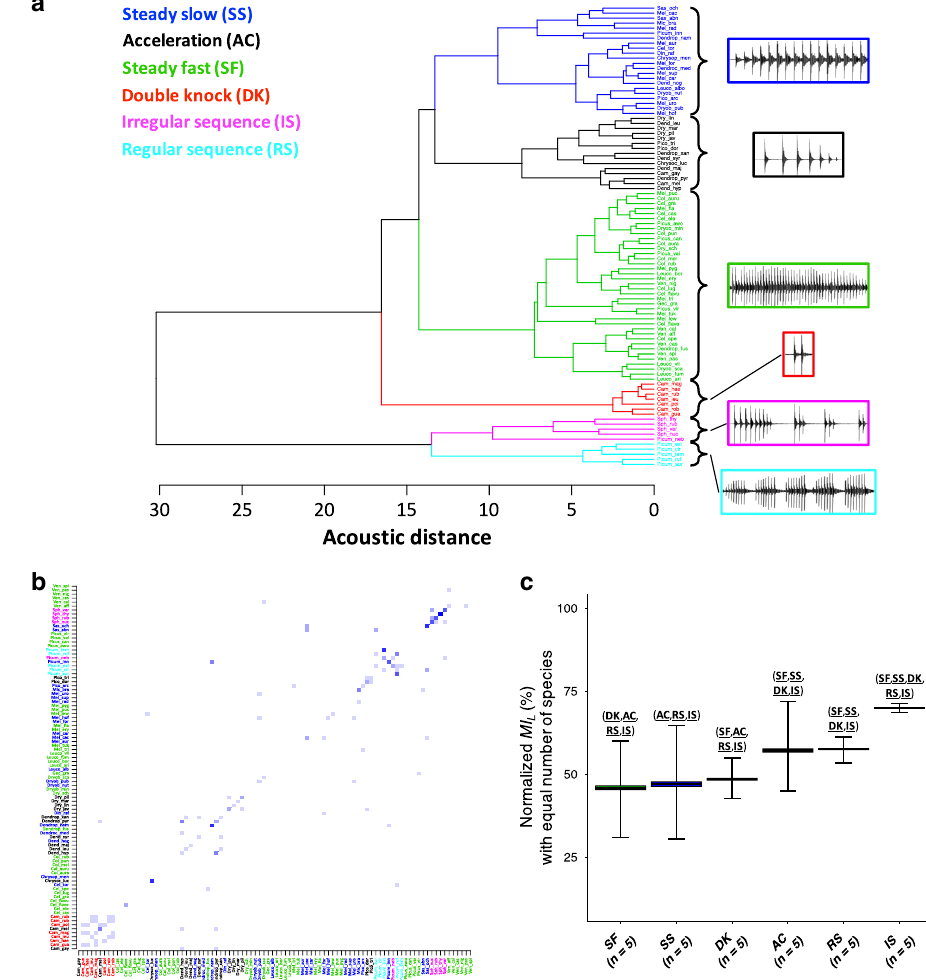
Fig. 2 Quanti fi cation of signal structure and information for species identity. a Hierarchical clustering of drumming signals based on acoustic Euclidean distances. Oscillograms illustrate the six drumming types: ‘ steady slow ’ , ‘ acceleration ’ , ‘ steady fast ’ , ‘ double knock ’ , ‘ irregular sequences ’ and ‘ regular sequences ’ (analysis based on 22 acoustic variables; n = 92 woodpecker species; 3 – 39 drums/species; see Methods ‘ Acoustic data and analysis ’ section). b Confusion Matrix showing the conditional probability of classi fi cation (given a speci fi c species) resulting from a discriminant function analysis (DFA) using the 6 principal components summarizing drumming acoustic structure. Rows ( Y axis) are actual species and columns ( X -axis) correspond to the species predicted by the DFA. Each row shows the conditional probabilities of predicting a speci fi c species shown on the X -axis given the species on the Y (cid:1) (cid:1)(cid:3) (cid:4) axis. This probability is written as p X M X A in the ‘ Methods ’ section. These probabilities are colour-coded on a blue scale, the darker the blue the higher the posterior probability (and thus the better the classi fi cation). Perfect classi fi cation would appear as a dark blue diagonal. Note the localized increase in misclassi fi cation occurring among closely related species (illustrated by ‘ clusters ’ of blue squares: species are ordered alphabetically, thus species from the same genus are adjacent on the x and y axes). c Normalized local mutual information ( MI L ) for each drumming type when considering equal number of species per type (100 iterations; box plots denote mean ± SE (boxes) and min/max values (whiskers); species were randomly selected for each iteration among the species available within their drumming type). Tests and signi fi cance levels are indicated as follows: (SF) signi fi cant difference with SF; (SS) signi fi cant difference with SS; (AC) signi fi cant difference with AC; (DK) signi fi cant difference with DK; (RS) signi fi cant difference with RS; (IS) signi fi cant difference with IS. Abbreviations without formatting indicate P < 0.05; abbreviations in bold indicate P < 0.005; abbreviations in bold and underscored indicate P < 0.001; P values are adjusted for multiple comparisons between groups (one-way ANOVA, Tukey post hoc test; two-sided statistics are reported). Source data are provided as a Source data fi